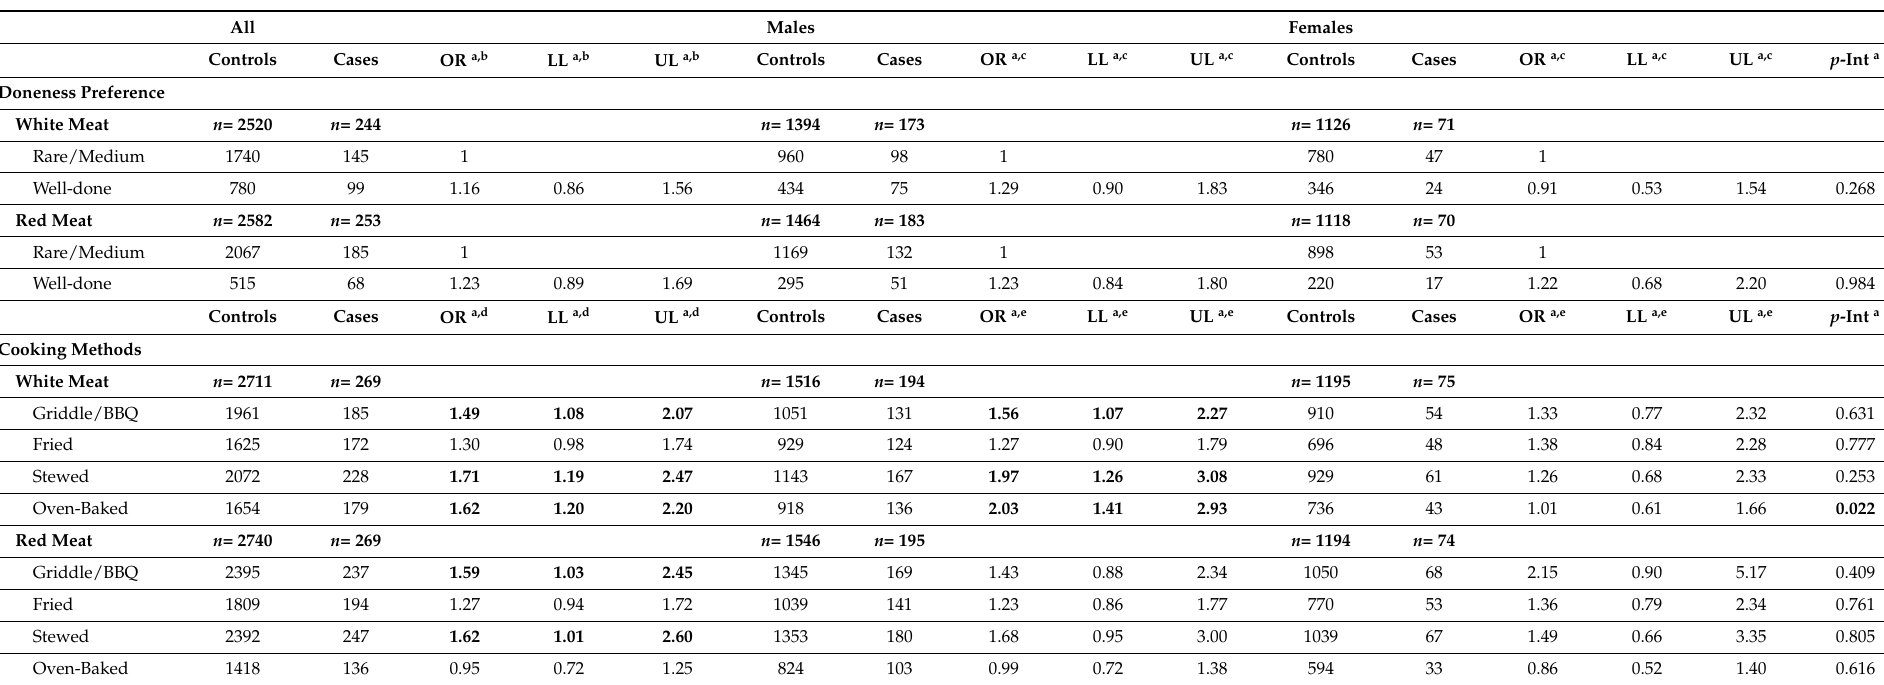
Table 5. Association between gastric adenocarcinoma incidence and meat-type specific doneness preference and cooking methods, overall and by sex (restricted to consumers of each type of